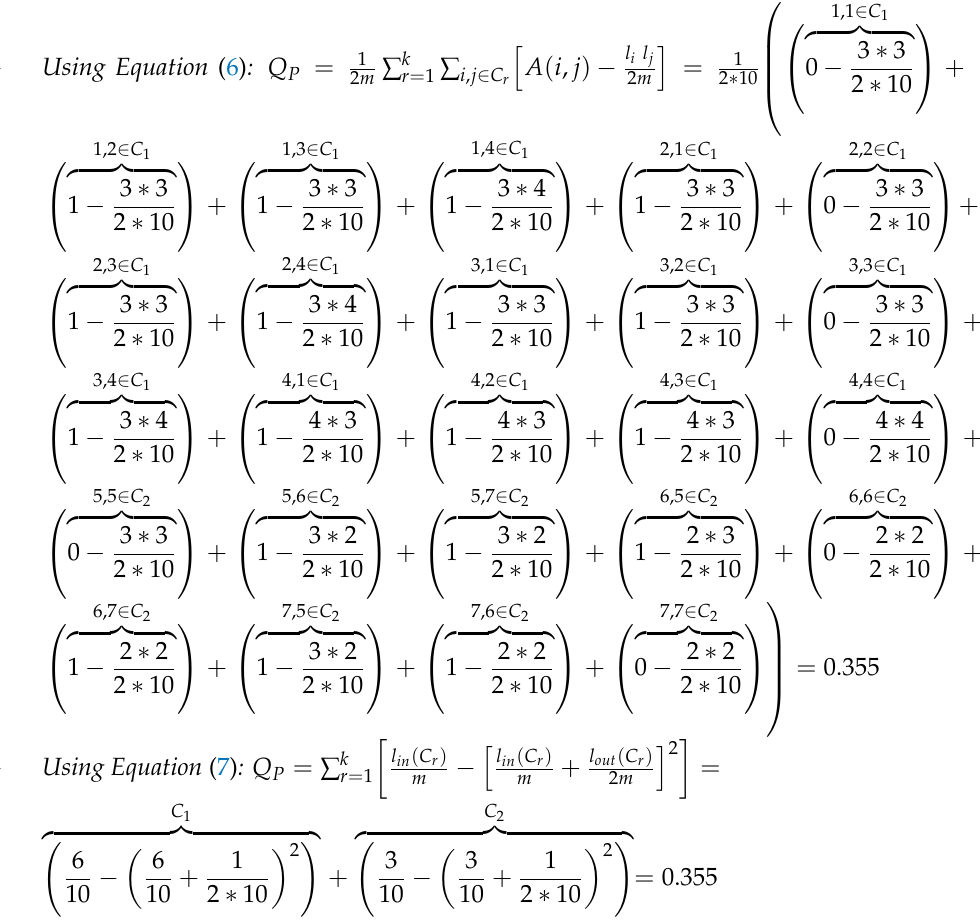
(cid:46) Using Equation (6) : Q